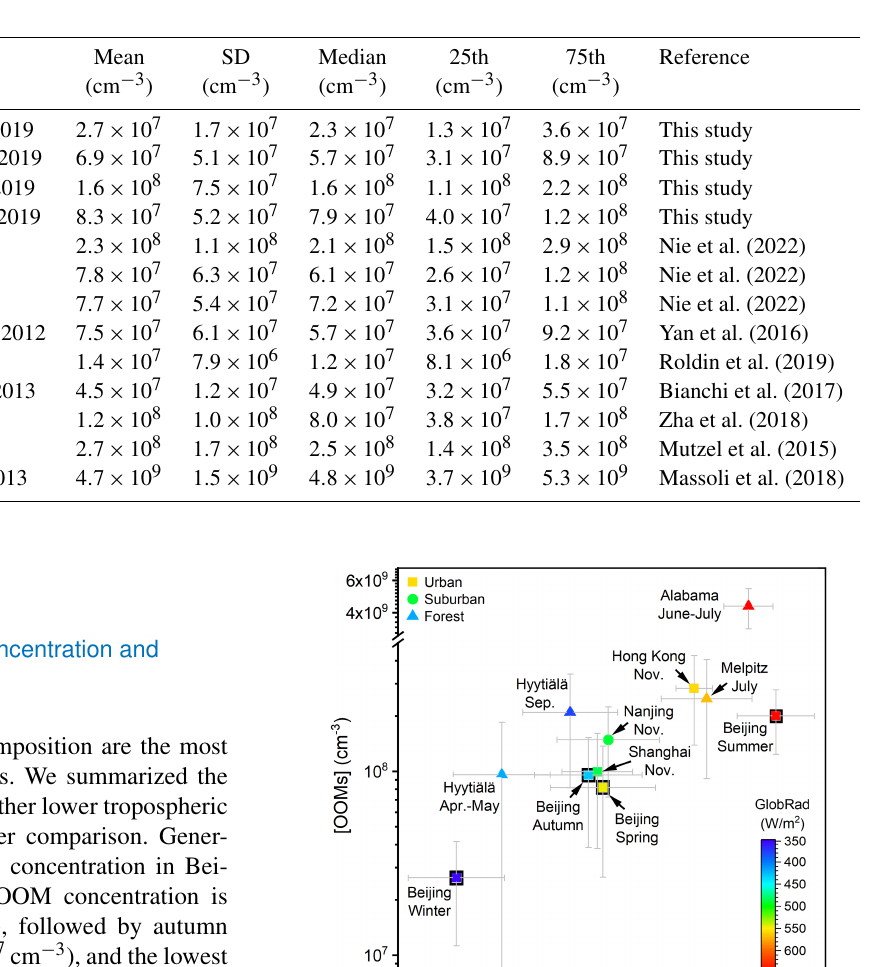
Table 1. Mean, standard deviation (SD), median, and 25 and 75 percentiles (25th and 75th) of measured OOM concentrations at various lower tropospheric sites.